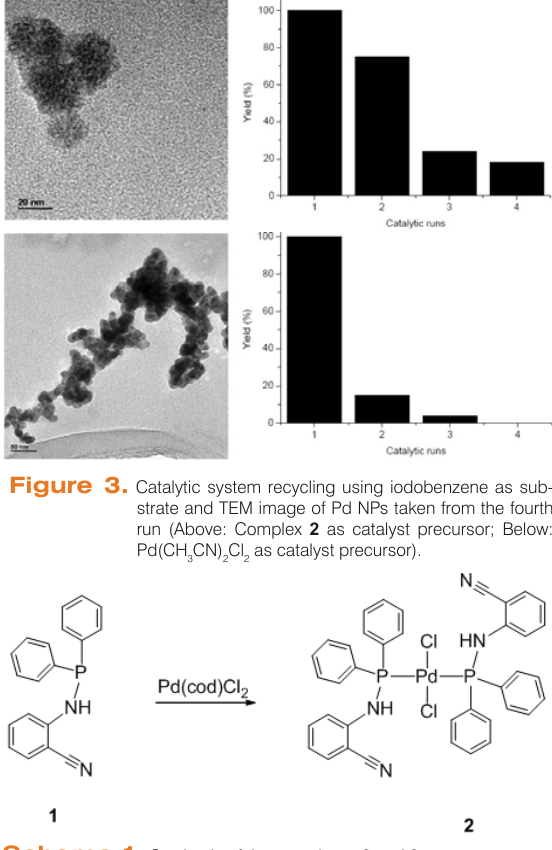
Table 2. Crystallographic data for of 2 ∙2(CH2Cl2).